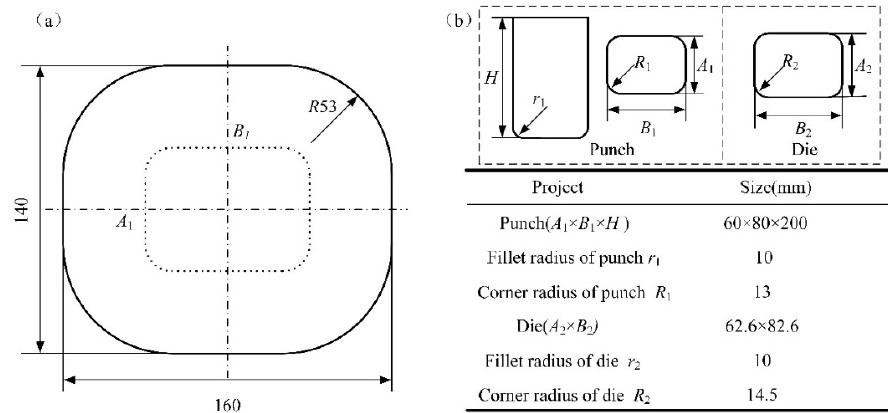
Figure 4. Dimensional specifications. ( a ) Blank size (mm); ( b ) die size.